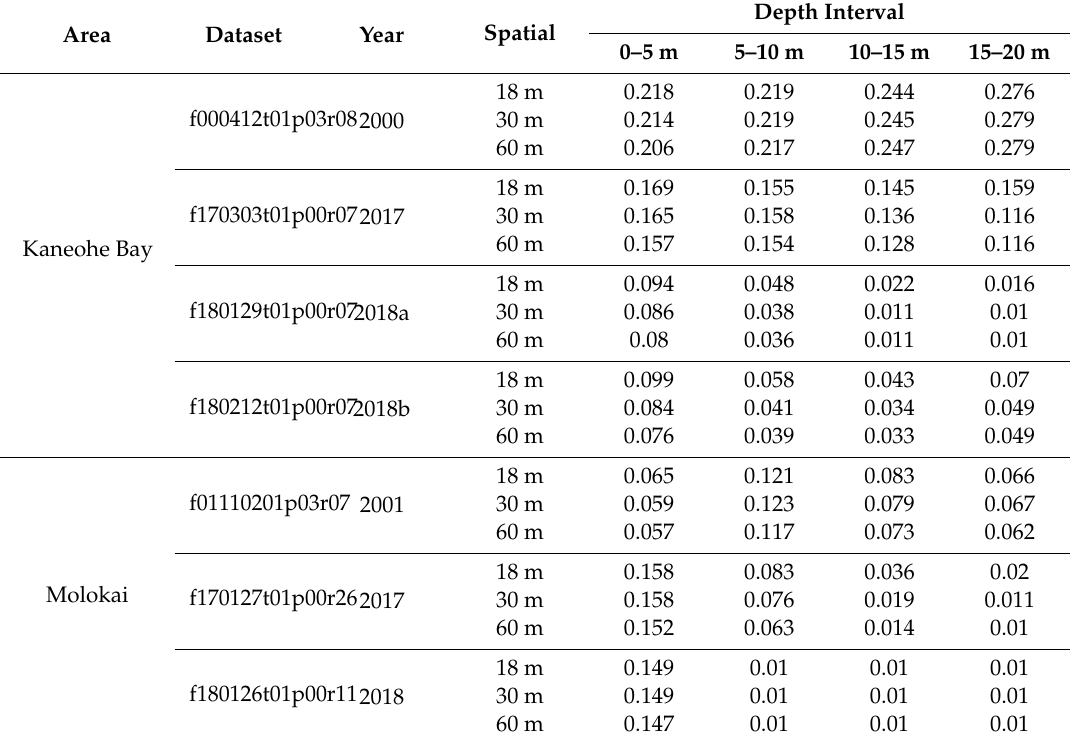
Table 4. Average benthic reflectance at 550 nm for Kaneohe Bay and Molokai at di ff erent depth intervals and spatial resolutions derived using bathymetric lidar data as input parameter to hyperspectral inversion